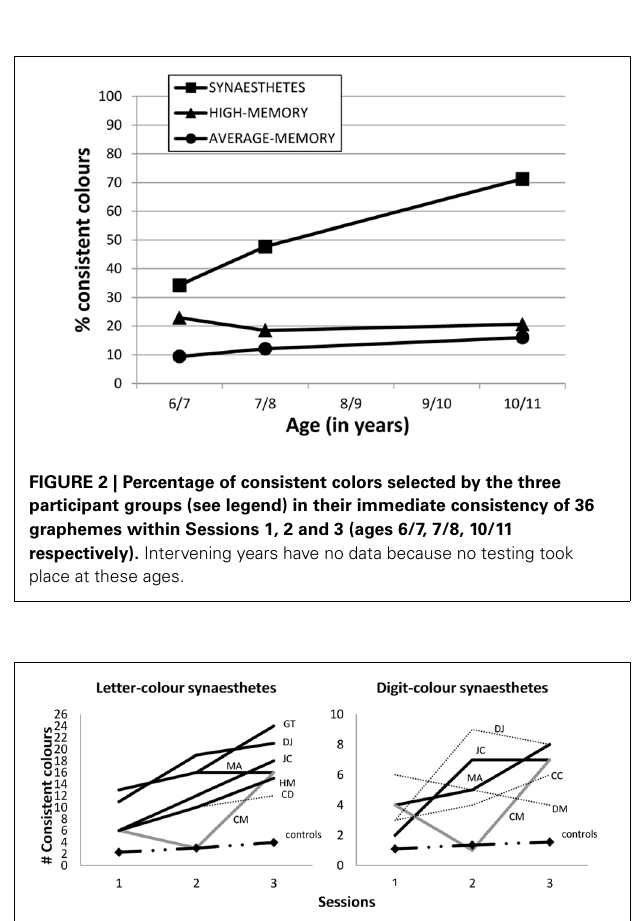
FIGURE 3 | Number of consistent colors selected within Sessions 1, 2 and 3 (ages 6/7, 7/8, 10/11 respectively) for letter-color synesthetes (out of 26; left panel) and digit-color synesthetes (out of 10; right panel). Black lines indicate Session 3 and 2 synesthetes; gray lines indicate Session 3 (only) synesthetes; dotted lines indicate Session 2 (only) synesthetes; dash/dotted lines with diamond data-markers indicate the means of average memory